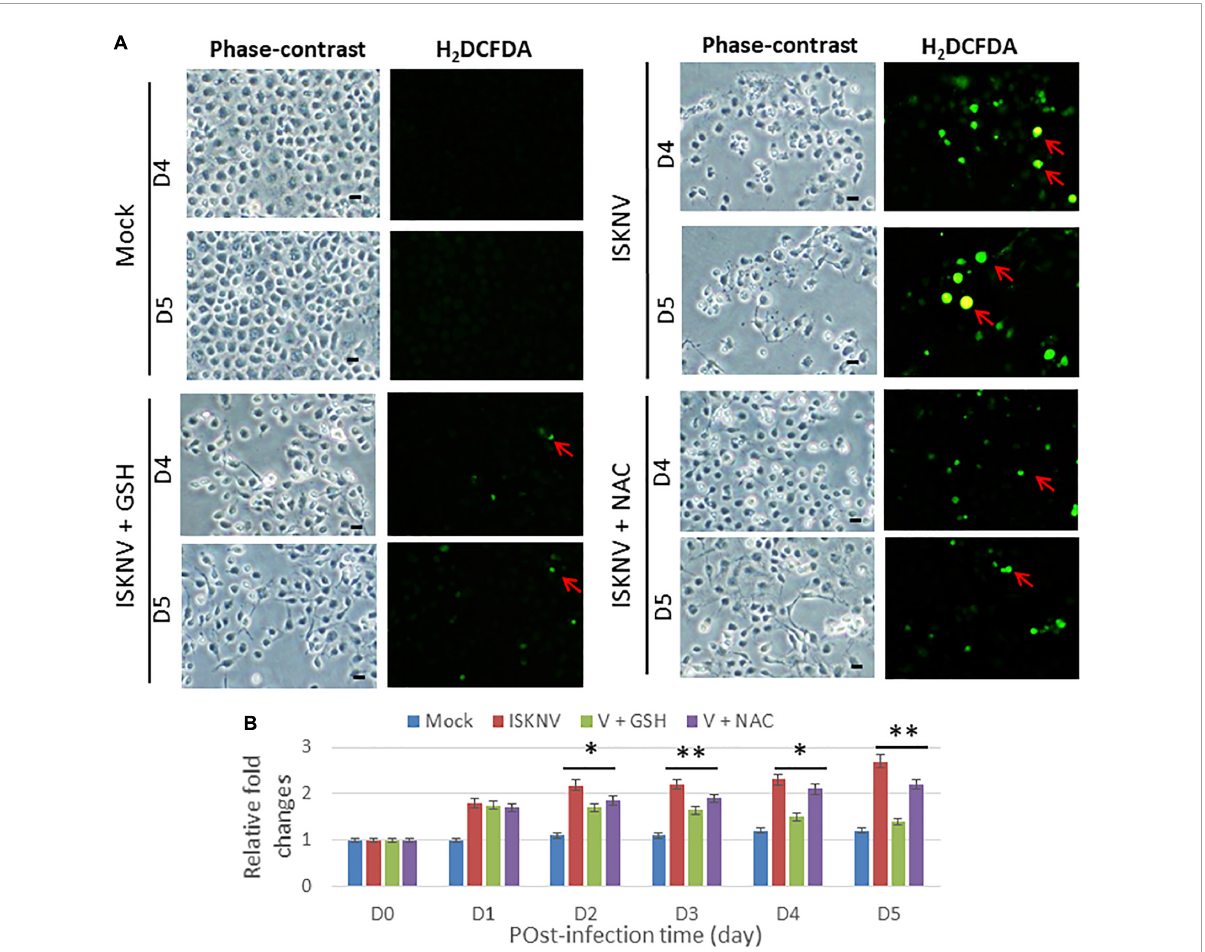
FIGURE2 Blockage of infectious spleen and kidney necrosis virus (ISKNV) induces reactive oxidative species (ROS) production via antioxidants in fish cells. (A) Phase-contrast/green fluorescence micrographs of ISKNV-infected and GSH- (2 mM) and NAC (2 mM)-treated fish cells at day 4 and day 5. Phase contrast images in which rounded-up cells were stained with H 2 DCFDA to examine ROS production: positive cells are indicated by red arrows. Scale bar = 10 µ m. (B) Relative fold changes in ROS production determined via an H 2 DCFD assay of ISKNV-infected cells at different time points. Day 0 of the mock group was used as the normal control and set at one-fold. The counting of virus-infected cells in each of the three images was repeated in three individual experiments using the ImageJ software. All data were analyzed using either paired or unpaired Student’s t -tests, as appropriate. ∗ P < 0.01 and ** P <